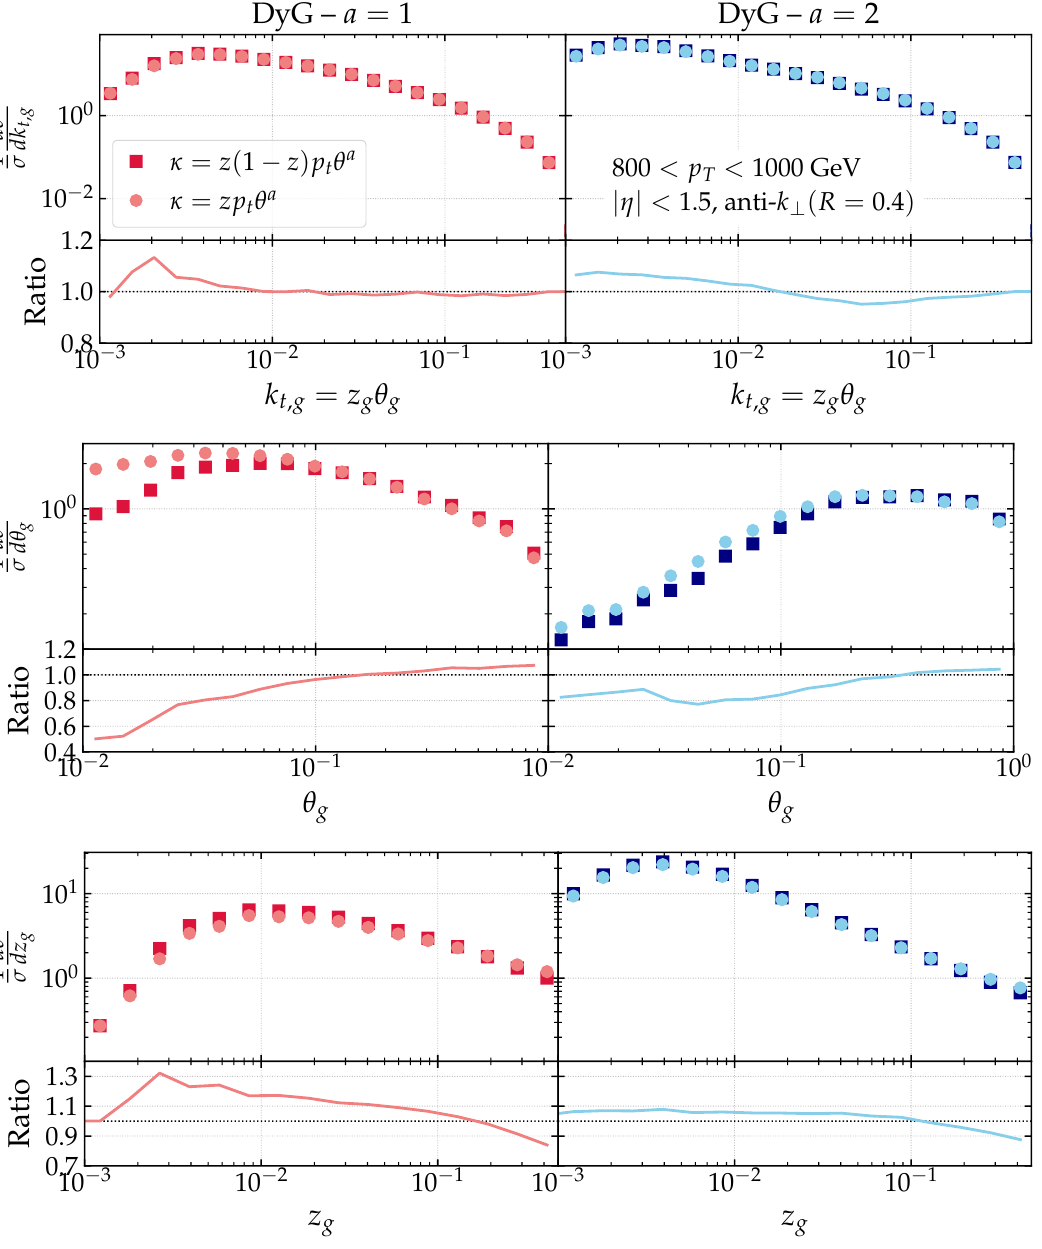
Figure 11 . Impact of including or not the recoil factor in the hardness variable definition as a function of a for dijet events at parton level in Pythia with and z g